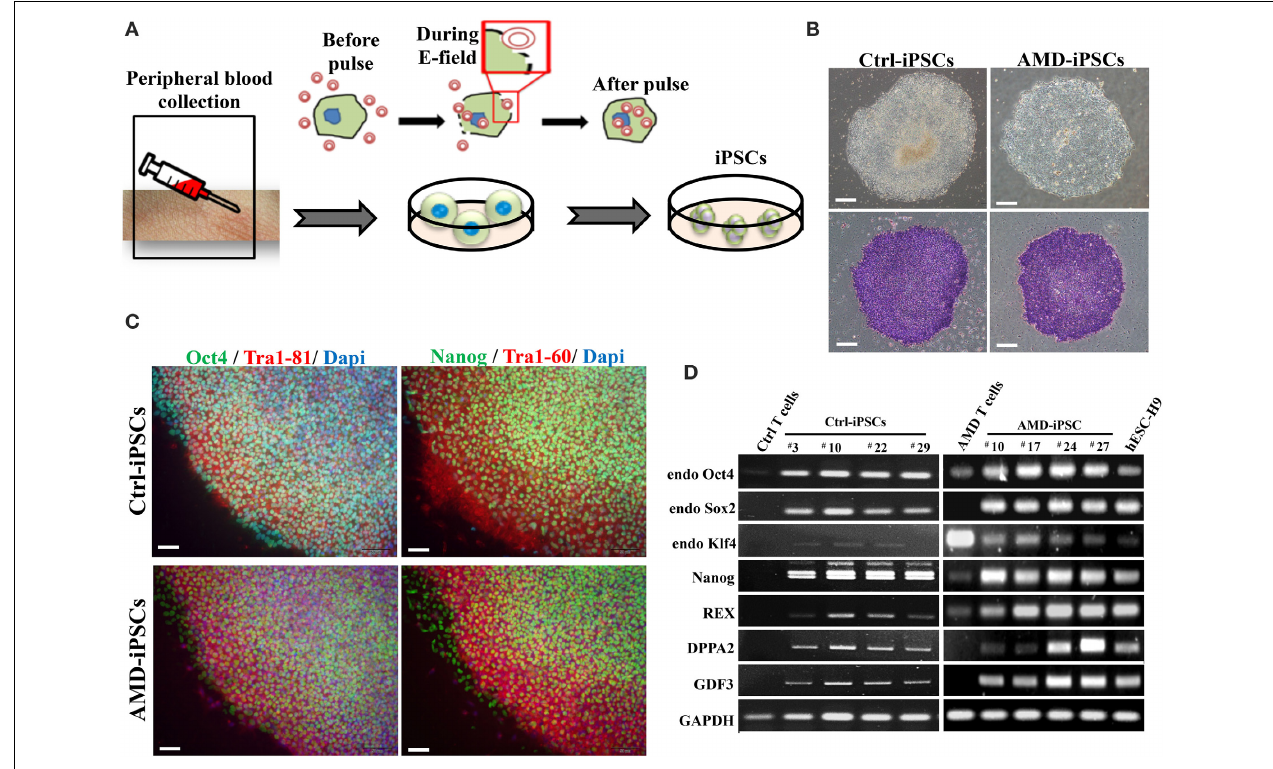
FIGURE 2 | Generation and characterization of iPSCs derived from patients with AMD and unaffected control. (A) Schematic diagram of the reprogramming with episomal plasmids via electroporation. (B) Phase-contrast photomicrograph and alkaline phosphatase activity of undifferentiated control iPSCs (Ctrl-iPSCs) and AMD iPSCs (AMD-iPSCs). Scale bar = 100 μ m. (C) Immunofluorescence staining demonstrated the